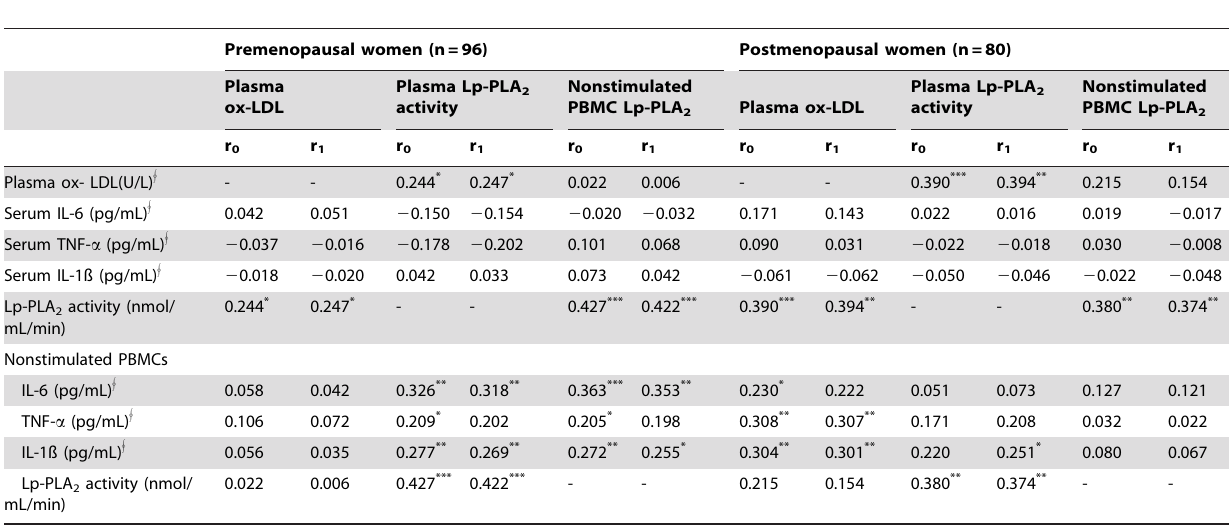
Table 3. Correlations among oxidative stress markers, cytokines, and Lp-PLA 2 activity in the circulation and in PBMCs according to menopausal status.